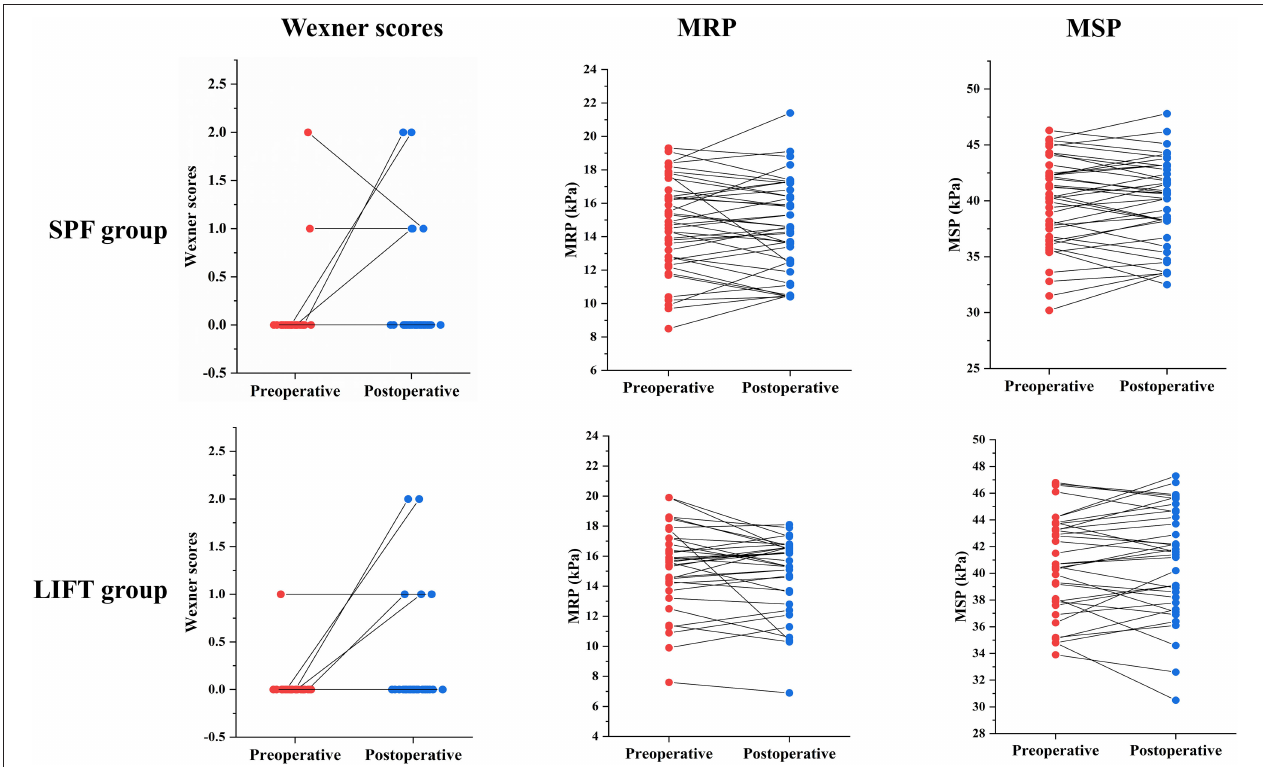
FIGURE 3 | Change of Wexner scores, MRP, and MSP before and after surgery in the SPF and LIFT groups. MRP, maximum resting anal canal pressure; MSP, maximum squeeze pressure; SPF, sphincter-preserving fistulectomy; LIFT, ligation of the intersphincteric fistula tract.